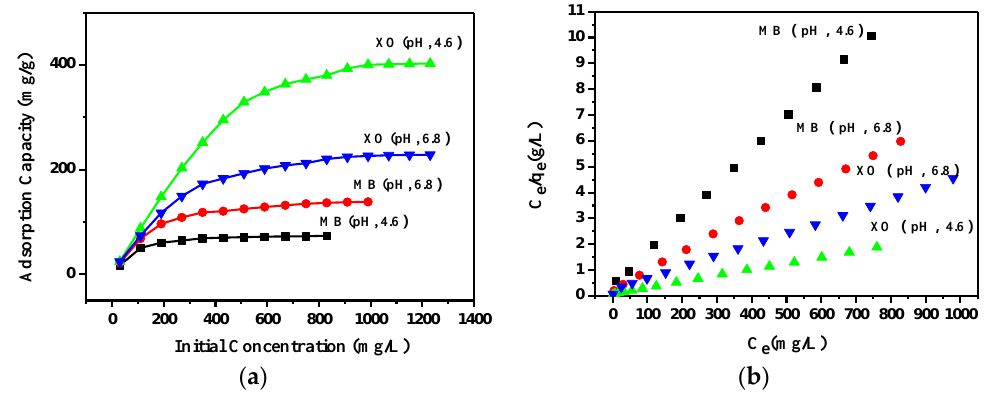
Figure 6. ( a ) Effect of initial concentration on dye adsorption by PEI-TORC membranes; ( b ) the plots of C e / q e against C e for adsorption of XO and MB at different pH.